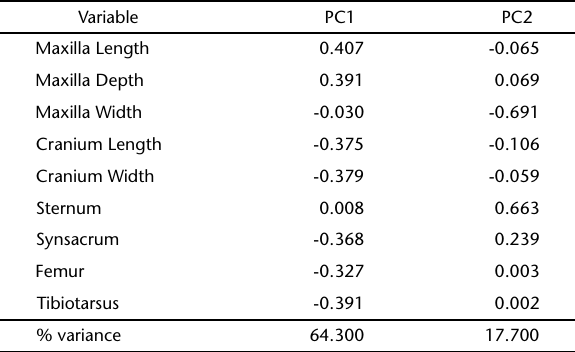
Figure 3. Parsimony-reconstructed PC1 scores across the phylog- eny of toucans. Table I. Variable loadings on the first two principal components (PC1 and PC2) derived from transformed skeletal measurements of 21 species of Ramphastidae.